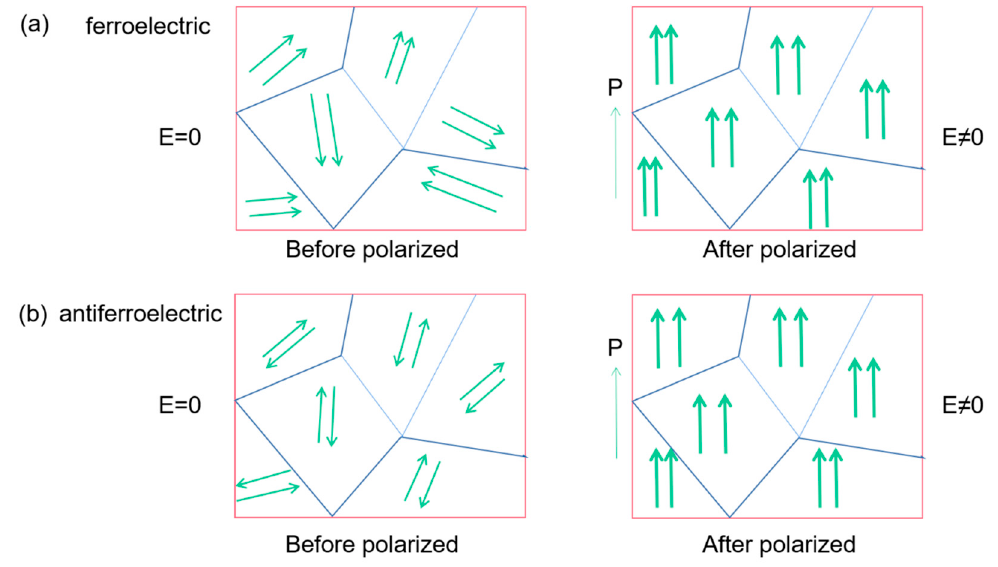
Figure 8. Schematic diagram of the polarization process in ferroelectrics and antiferroelectrics. The arrows indicate the polarization orientation. ( a ) Ferroelectric, the adjacent dipoles in the same domain are arranged in parallel. ( b ) Antiferroelectric, the adjacent dipoles in the same domain are arranged in reverse parallel.